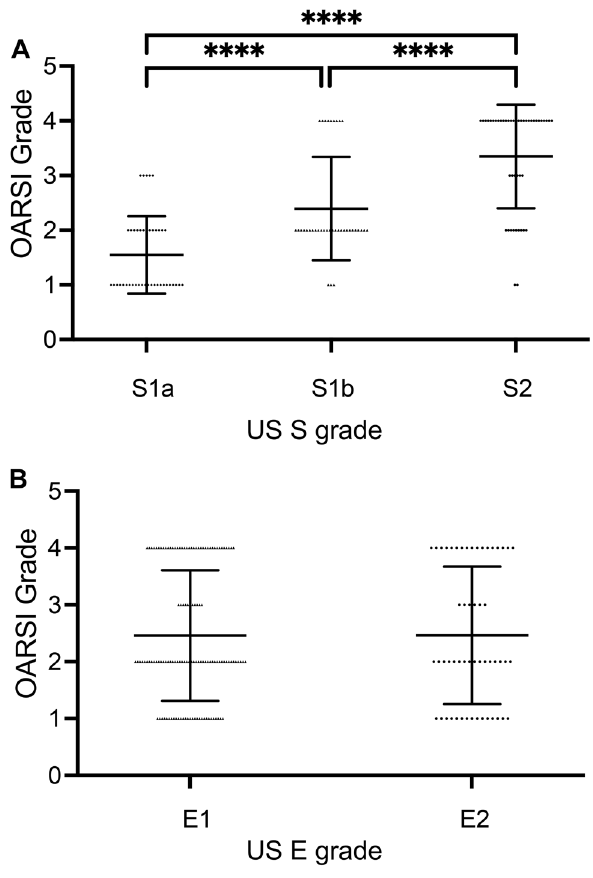
Figure 3. Ultrasound grade and the OARSI osteoarthritis cartilage histopathology assessment system. The relation of OARSI grade with ( A ) US S grade, ( B ) US E grade. The mean OARSI grade in each US grade (mean ± SD). **** p <